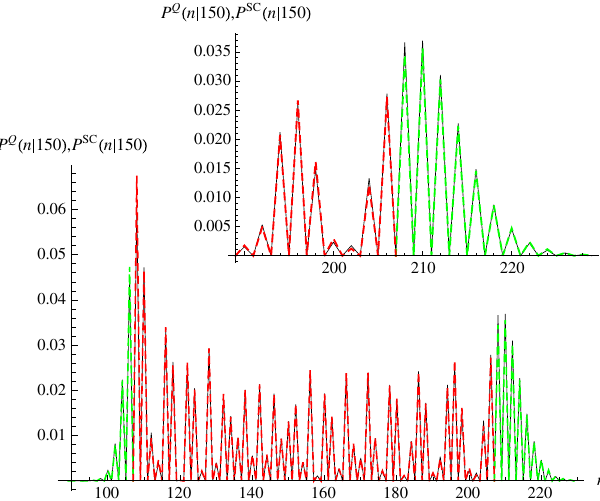
FIG. 9. Comparison between the quantum transition probabil- ities evaluated by numerical integration of the Schrödinger equation (black, solid line) and the semiclassical approximations given by Eq. (49) in the central region 110 < n < 200 (red, dashed line) and by Eq. (69) in the boundary regions 90 < n < 110 and 200 < n < 230 (green, dashed